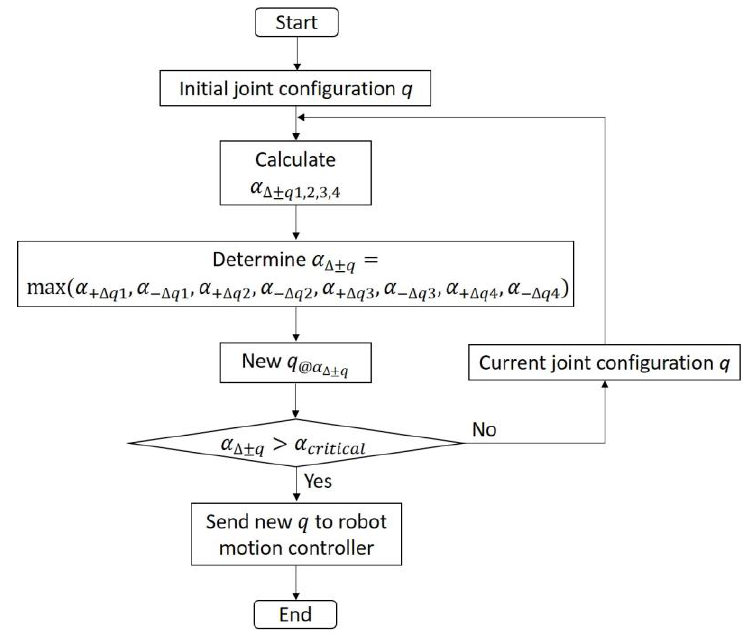
Figure 14. Discretization of workspace for the implementation of the gradient function.